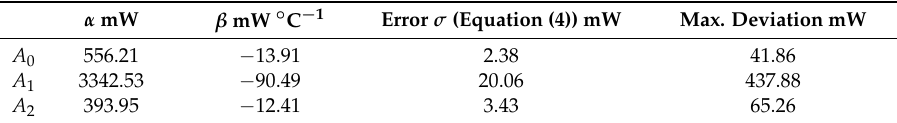
Figure 9. Adjustment errors of the calorimetric curve (Equation (7)) in the determination of the coefficients A 0 , A 1 and A 2 represented in Figure 8. Measurements were made on the right hand (blue points) and the left hand (red points) of a healthy 23-year-old male subject, which was measured with the minisensor S1 (round) and the minisensor S2 (squares) for different thermostat temperatures ( Tcal ). Table 3. Parameters of the fitting lines ( A i = α + β T cal ) of the coefficients A 0 , A 1 and A 2 , as represented in Figure 8.